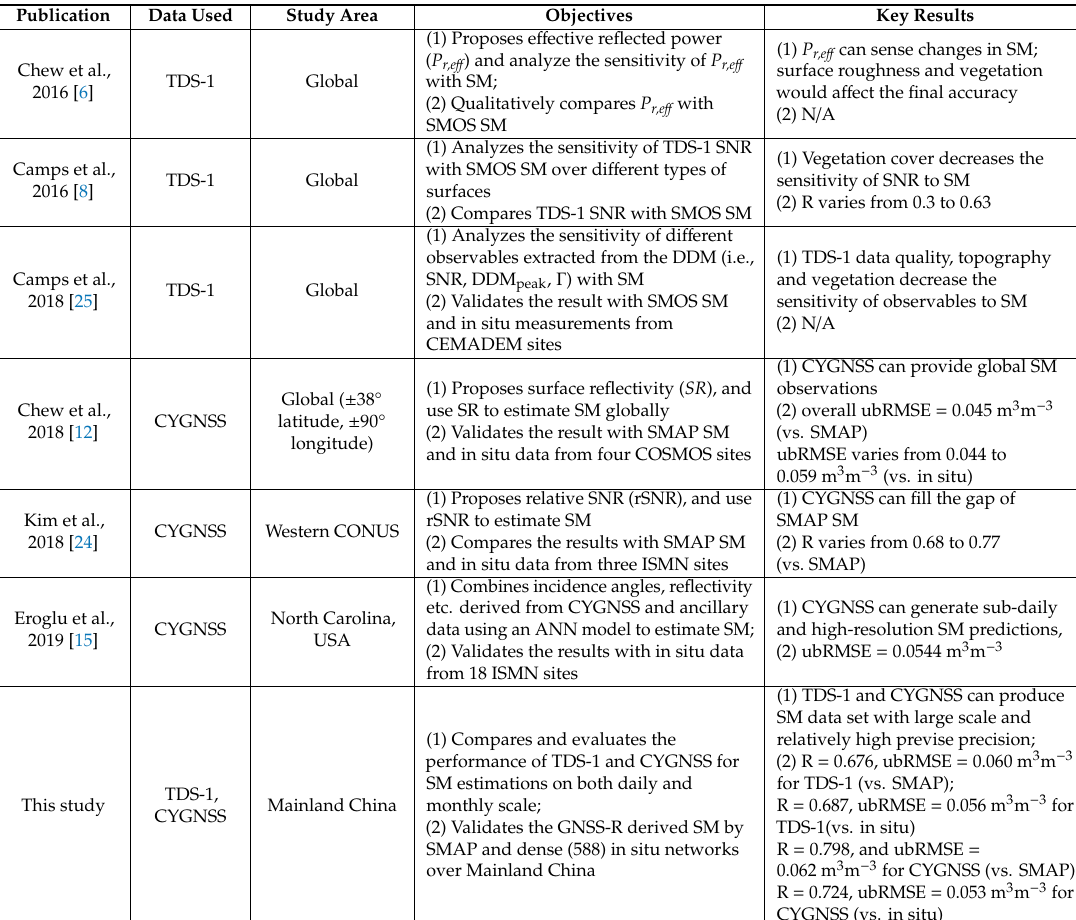
Table 2. Summary of relevant studies using TDS-1 and CYGNSS to estimate SM. The “key results” column is summarized from the following two aspects: (1) key conclusion and (2) accuracy evaluations. N / A represents “not